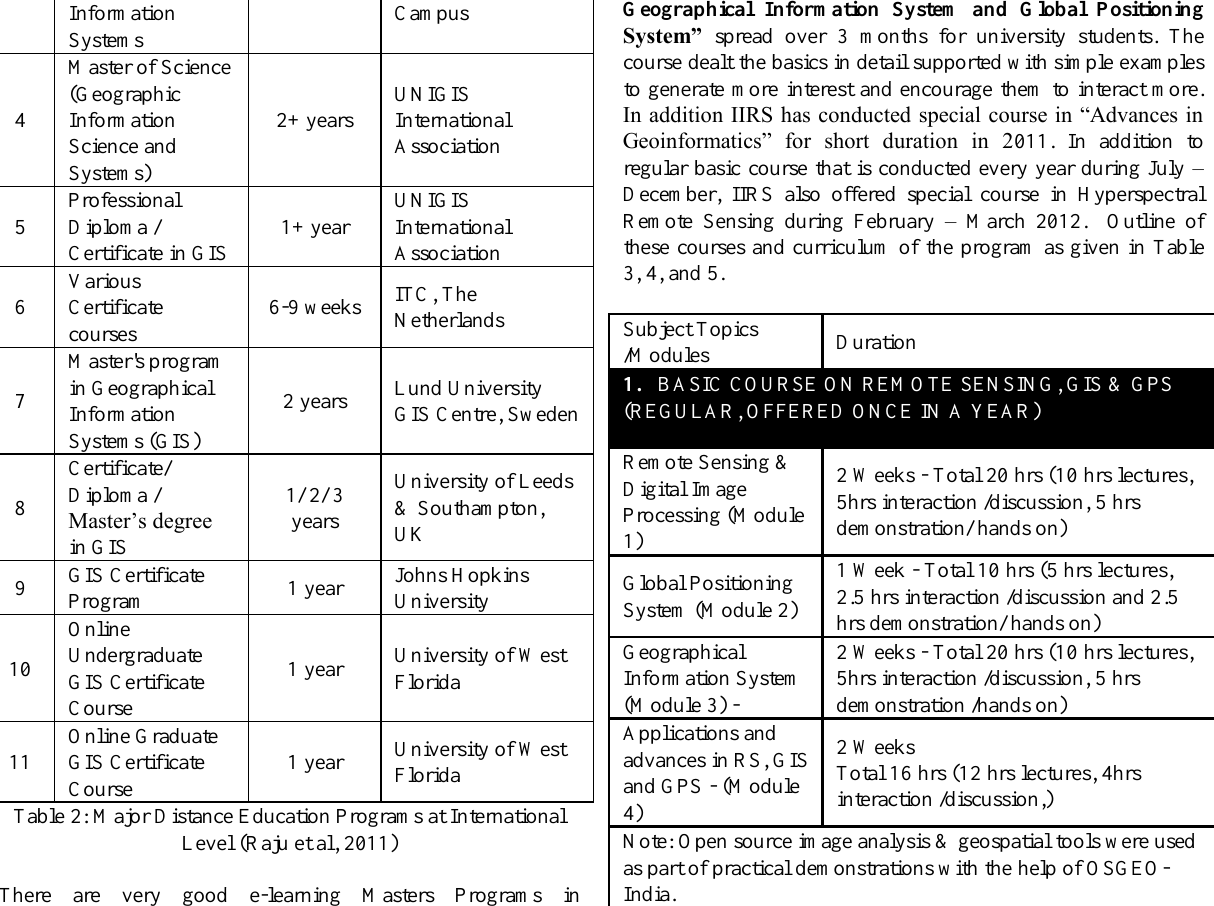
Table 3: Course Structure and syllabus of Basic Course on